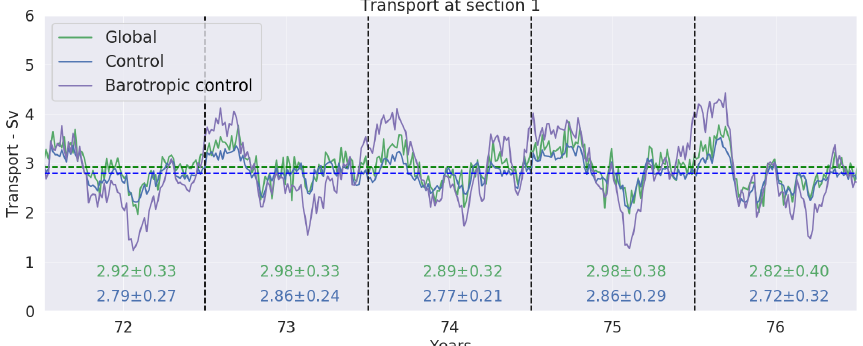
Figure 3. Time evolution of the volume transport of waters of potential density greater than σ 0 = 27 . 80kgm − 3 at the sill section (section 1 in Fig. 1) in the control (blue line) and the global (green line) simulations (the latter providing the open boundary conditions). Annual mean and SD (Sv) are indicated for every individual year of simulation. The depth-integrated (barotropic) transport is shown for the control simulation (purple line). 5d mean values were used to produce this